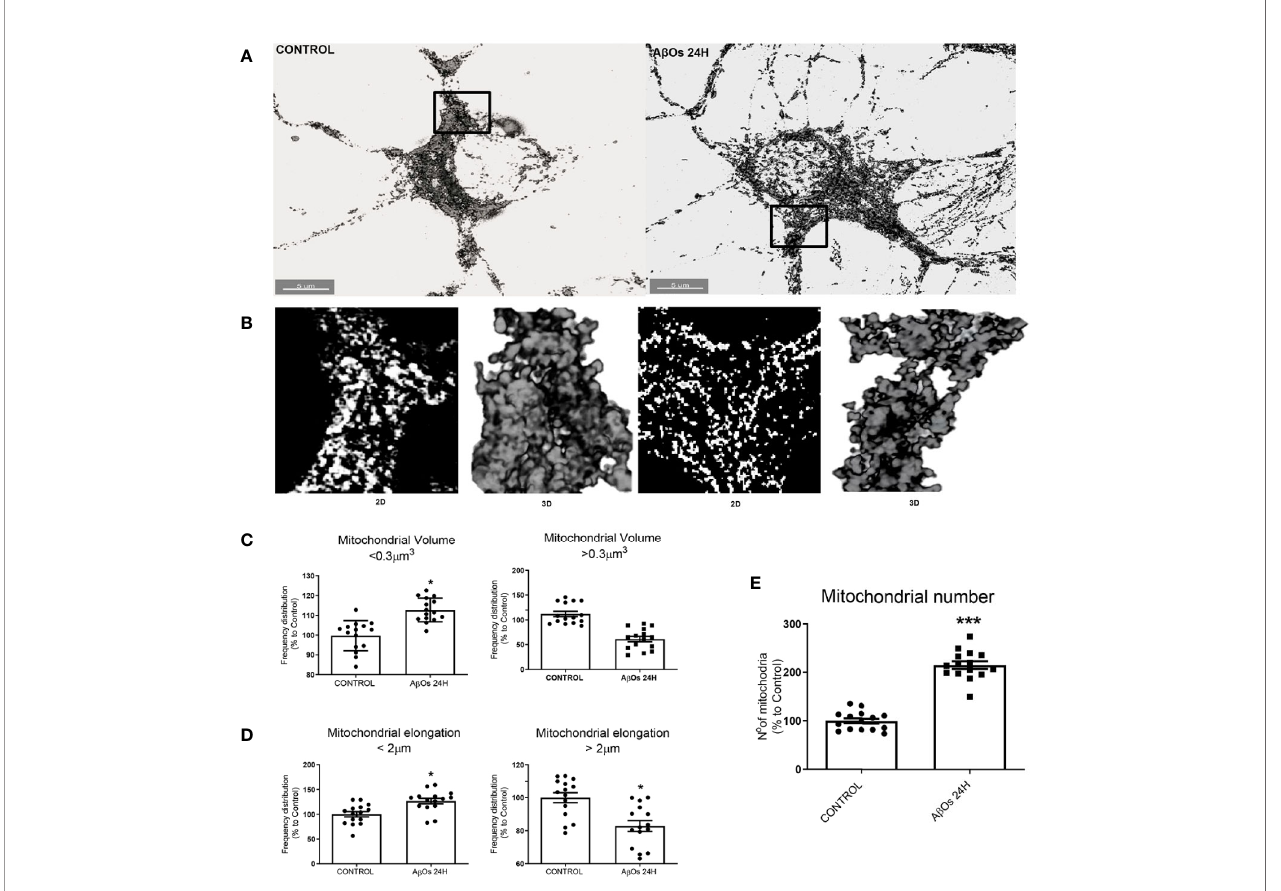
FIGURE 5 | Changes in mitochondrial network size after acute and chronic exposure to A b Os in hippocampal neurons. (A) Super-resolution images of hippocampal neurons showing the immunoreactivity for the speci fi c primary antibody for TOM 20 (white) in control condition (left panel) and after 24 h of incubation with A b Os (0.5 µM; right panel). (B) Representative 2D and 3D images of mitochondrial population in fi gure A. (C) The data were analyzed as the percentages of number for volume (> and < 0.3 m m3, C ), length (> and < 2 m m, D ), and number (E) of mitochondrial population in A b Os treated cells compared with untreated cells. Scale bars: 5 m m. Data are represented as mean ± SEM. *p < 0.05, ***p < 0.001 compared between the control group. Student's t-test followed by unpaired t-test was used for all statistical analyses. TOM20, translocase of outer membrane. (n=3, N=15) (complete inmunocytochemistry for TOM20 with controls are provided on Supplementary Figure 5